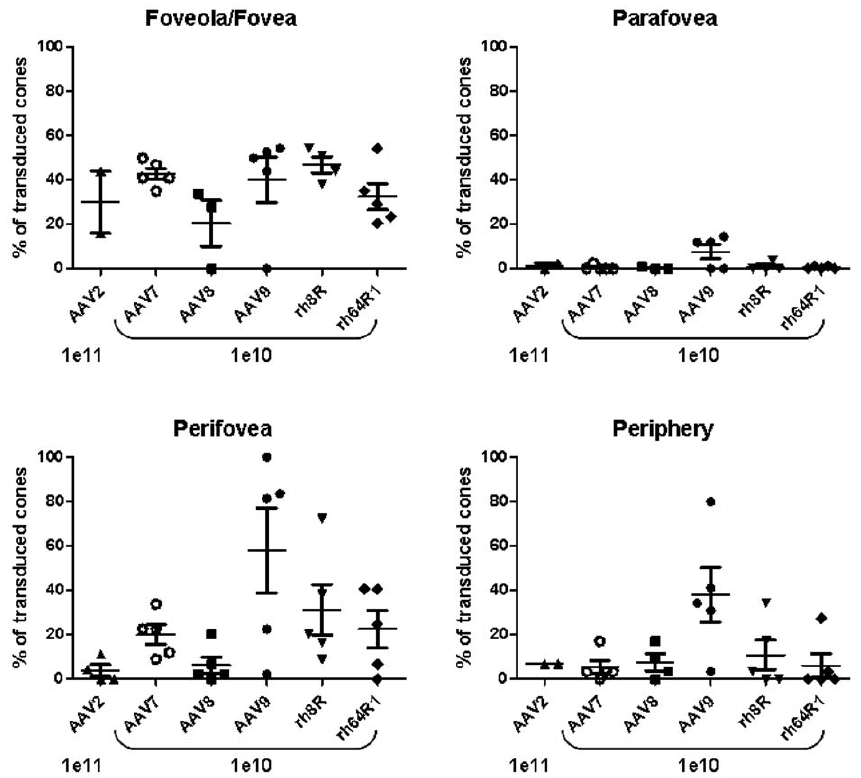
Figure 3. Quantitative assessment of cone photoreceptor transduction across the nonhuman primate retina. For each eye and for each of the foveal, parafoveal, perifoveal and peripheral retina regions, GFP positive cones were counted on histological sections. Shown is the percentage of the average number of GFP-positive cones relative to the average total cone number for each eye and region. Each eye for which viable sections were available was included in this analysis, including those for which the injection was suboptimal or problematic and the bleb may not have extended across the fovea/parafovea.